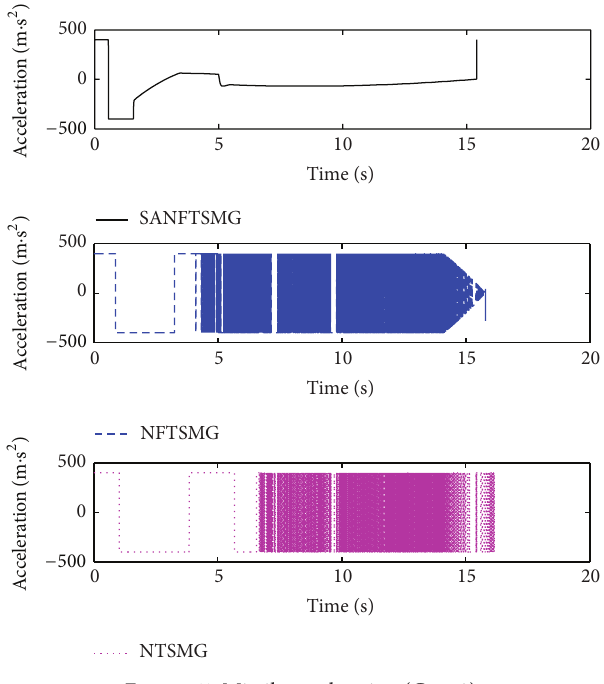
Figure 11: Missile acceleration (Case 2).